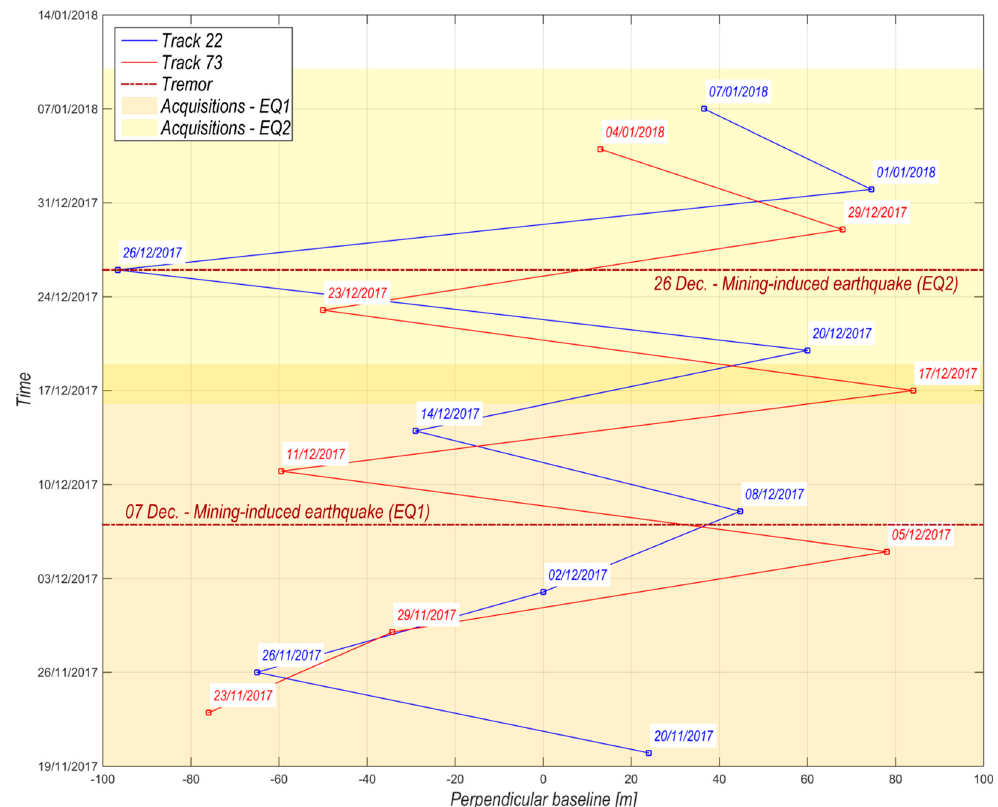
Figure 5. The spatial and temporal baselines of Sentinel-1 Synthetic Aperture Radar (SAR) images used in the investigation (ascending orbit—red, descending orbit—blue, data of acquisition is labeled). The red and blue lines represent the analyzed interferograms with the dates of their acquisitions. The dates of mining-induced earthquake occurrence have been indicated by dashed brown lines. The time period of the SAR image acquisition for the two tremors has been shown using light yellow (EQ1) and light orange (EQ2).